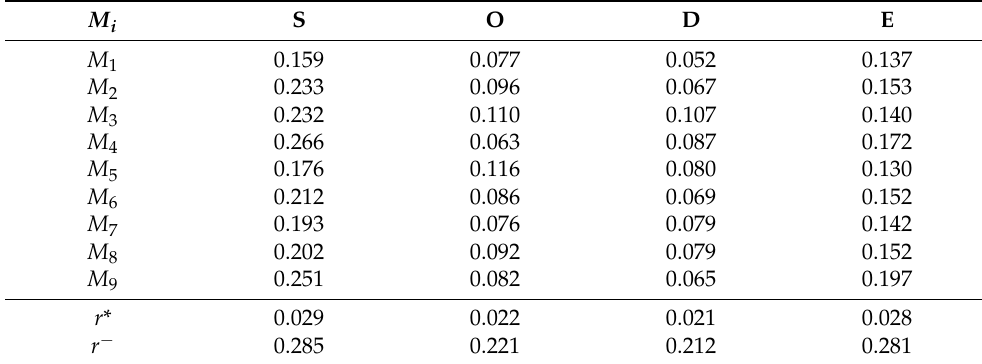
Table 9. The weighted normalized matrix F .